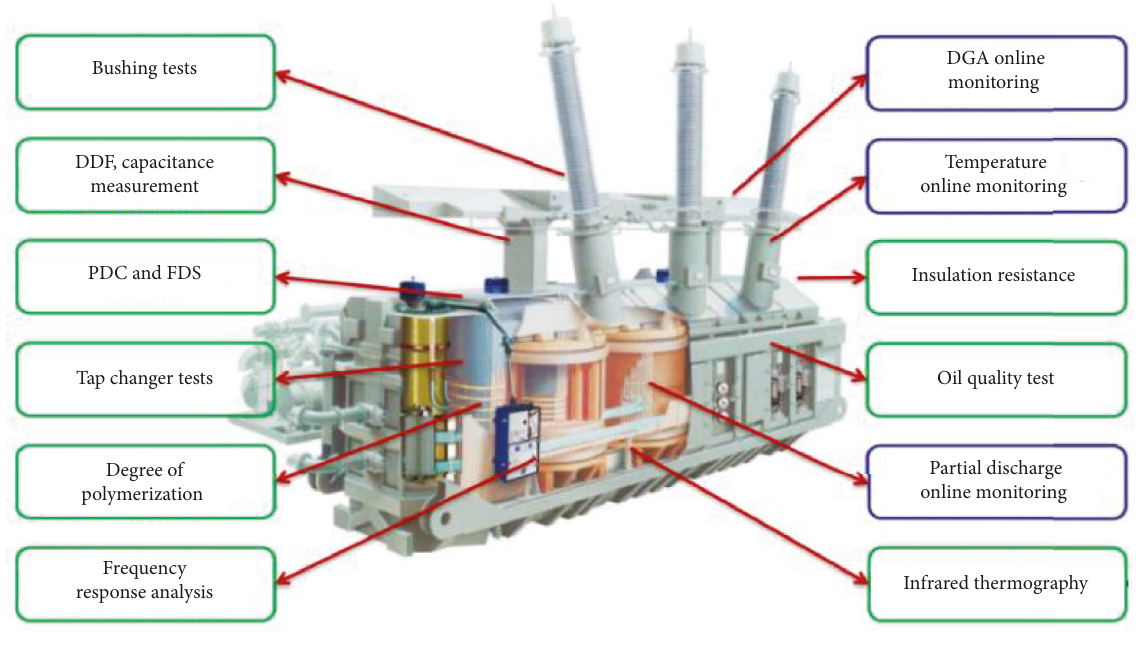
Figure 1: Typical transformer diagnostic